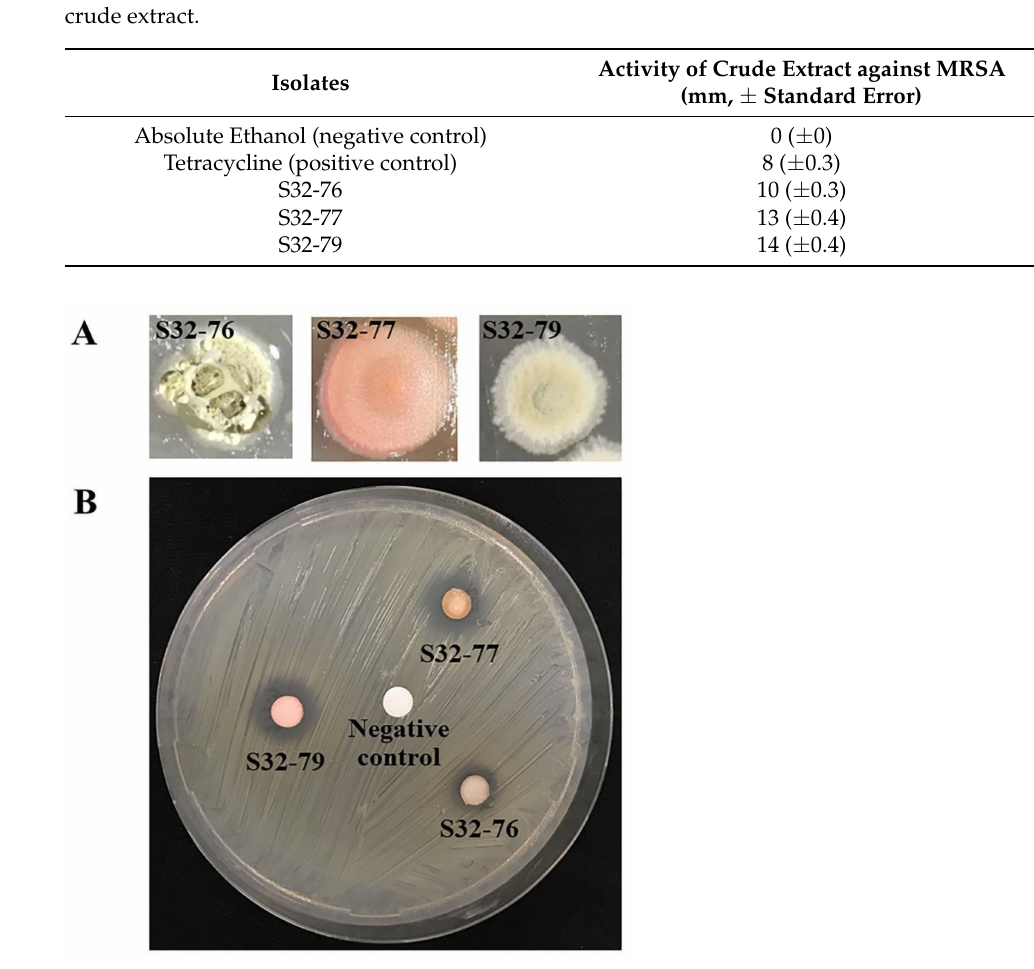
Figure 7. Colonies of three selected Streptomyces isolates (strains S32-76, S32-77, and S32-79) ( A ); and their activities against MRSA in their ethyl acetate extracts of cell culture supernatant ( B ). In ( A ), colony morphology was observed on an ISP3 medium after seven days of incubation at 28 ◦ C under stereomicroscope. In ( B ), three paper disks (6 mm in diameter) loaded with 40 µ L of crude extracts were plated on nutrient agar overlayed by MRSA. The center was a negative control disk loaded with 40 µ L of absolute ethanol. All discs were completely dried before placing on the